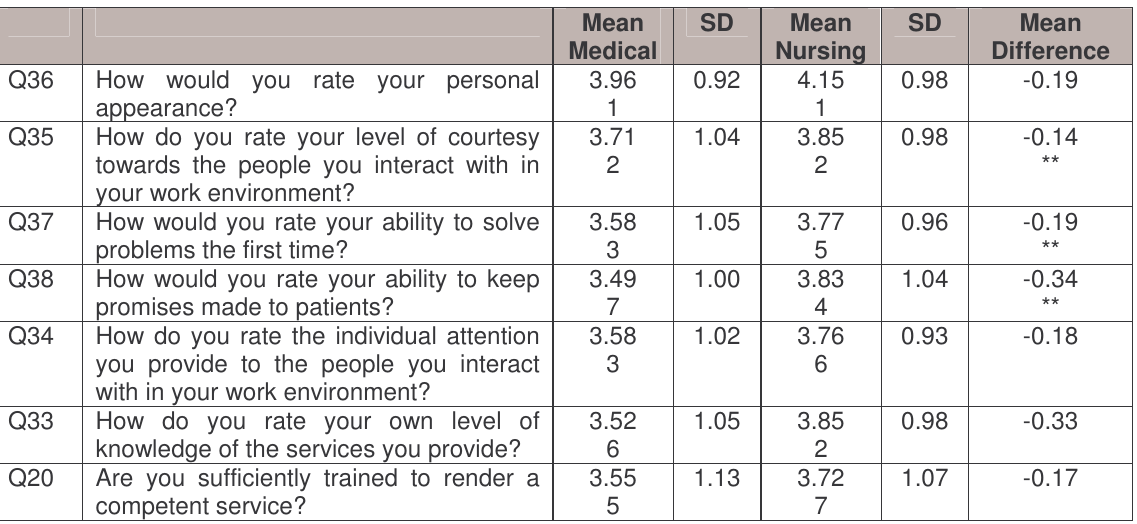
Table 1: Customer service (Average mean 3.73)